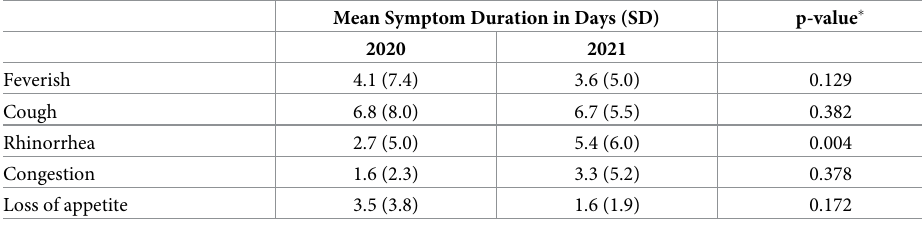
Table 5. Symptom duration comparison: SARS-CoV-2 by